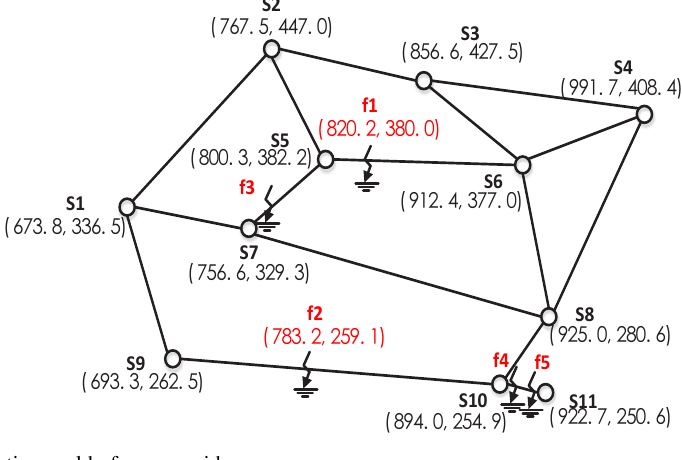
Fig.2. Simulation mold of power